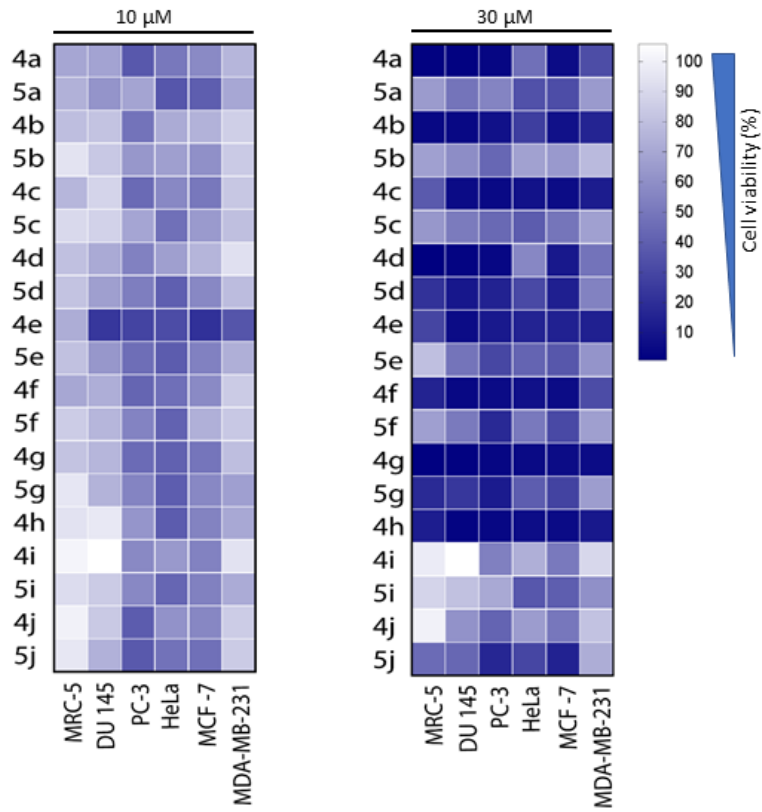
Figure 3. Primary antiproliferative action of the synthesized DHT derivatives on different cell lines. Table 2. IC 50 values ( µ M ± SD) of the selected compounds determined on various cancer cell lines and on non-cancerous MRC-5